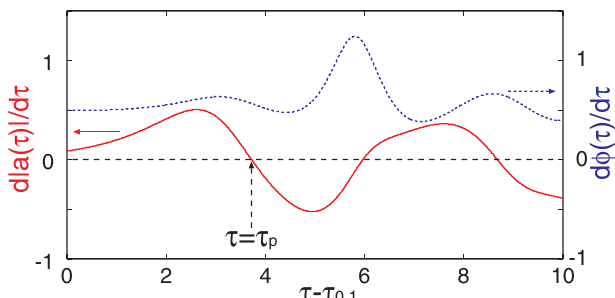
FIG. 5. (Color) The amplitude gain d j a (cid:2) (cid:6) (cid:4)j =d(cid:6) (solid line) and phase shift d(cid:9) (cid:2) (cid:6) (cid:4) =d(cid:6) (dotted line) calculated numerically from the 1D FEL equations given by Eqs. (25)–(28) as a function of (cid:6) (cid:7) (cid:6) . The gain is zero at (cid:6) . The initial values for the p 0 : 1 calculation are given by Eqs. (22)–(24).